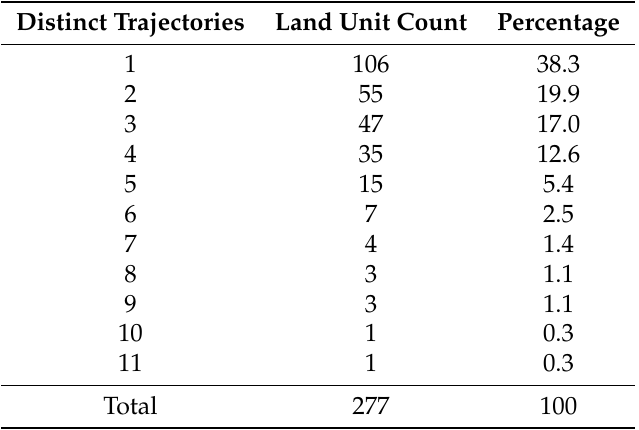
Table 8. Number of distinct trajectories assigned and corresponding land unit count.